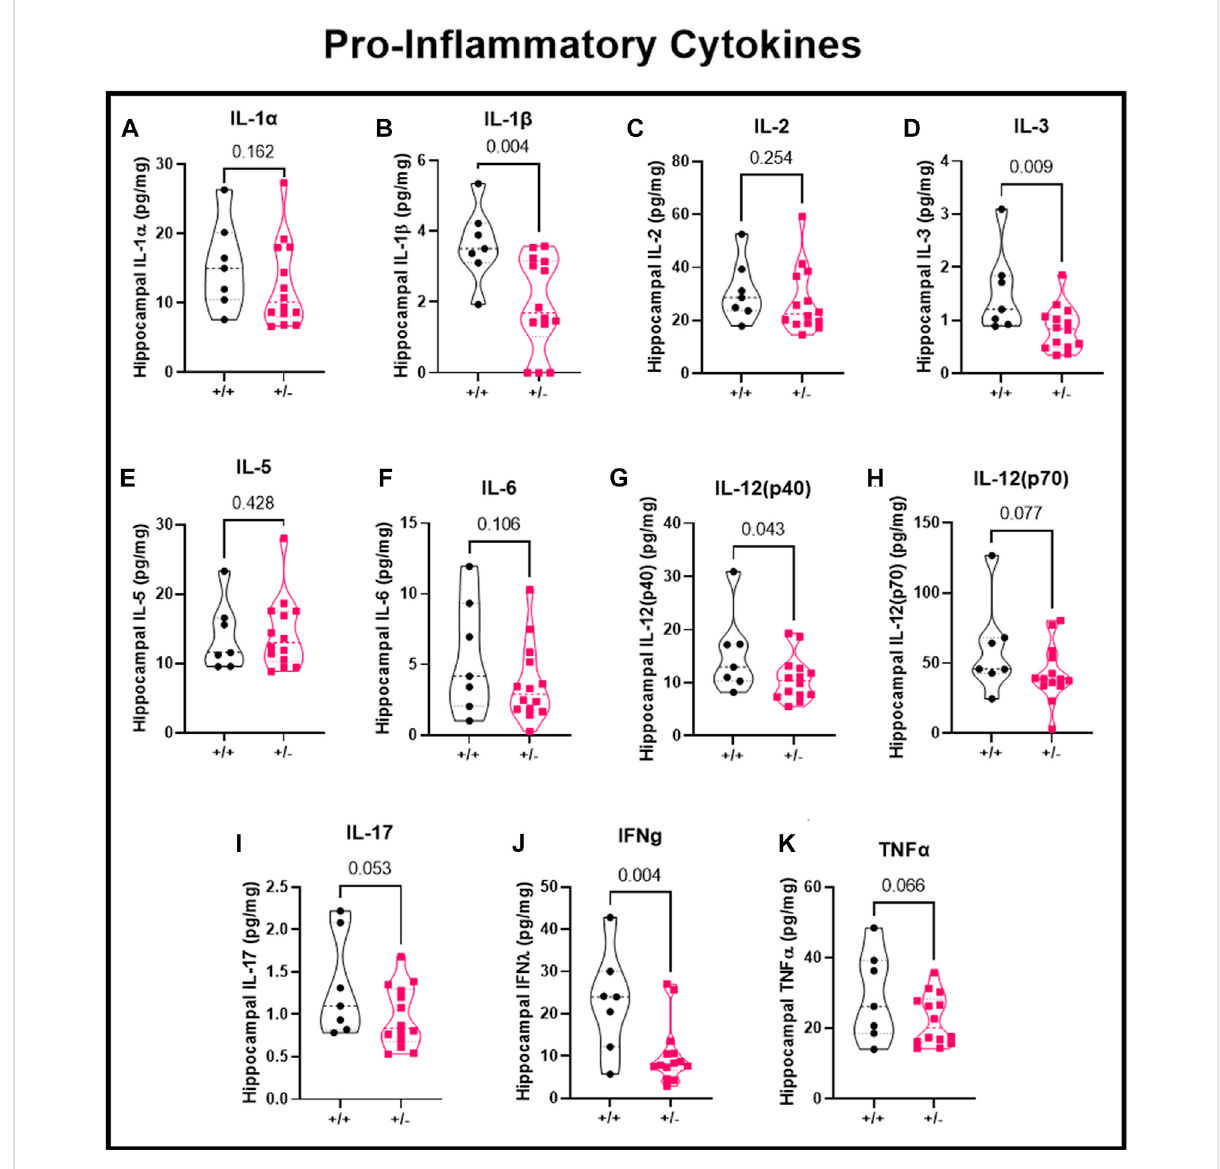
FIGURE 5 Changes in hippocampal pro-in fl ammatory cytokines following seizures. Seizure exposure resulted in (A) no change in IL-1 α , (B) decreased IL- 1 β , (C) nochangeinIL-2, (D) decreasedIL-3, (E) nochangeinIL-5, (F) nochangeinIL-6, (G) nochangeinIL-12(p40),or (H) IL-12(p70),or (I) IL-17, (J) decreasedIFN γ ,and (K) nochangeinTNF α inhippocampalcytosolicfractionatGD18.5ofpregnancy.N=7or14pergenotype.Individualdatapoints aredisplayed.ThickdashedlineisthemedianandthethindashedlinesarethequartilesSigni fi cancewascalculatedusingMann-Whitney U